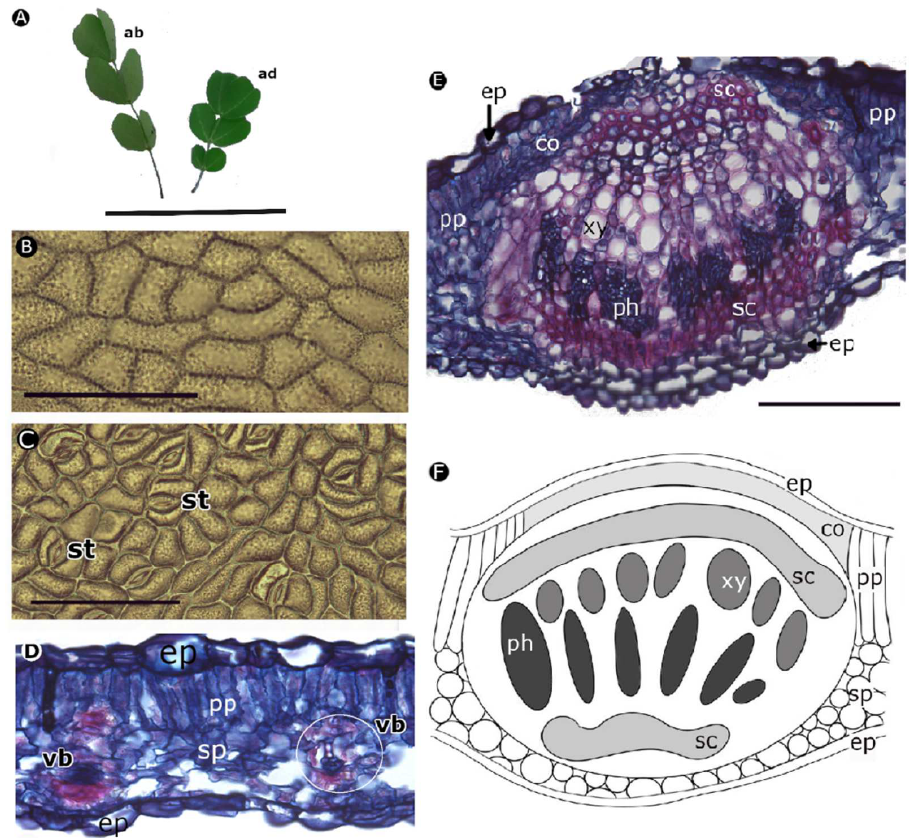
Figure 4. Morpho-anatomy of leaves of Haematoxylum brasiletto [( D , E ): optical microscopy, sections stained with basic fuchsin and astra blue]. ( A ) Leaves; ( B ) adaxial side; ( C ) abaxial side; ( D ): foliar